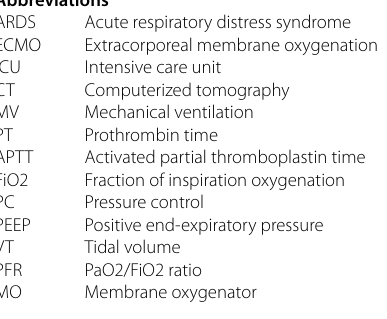
right jugular vein and the right femoral vein. JL collected and analyzed clinical data. SS and FQ made a decision on therapy strategies. All authors read and approved the final manuscript.